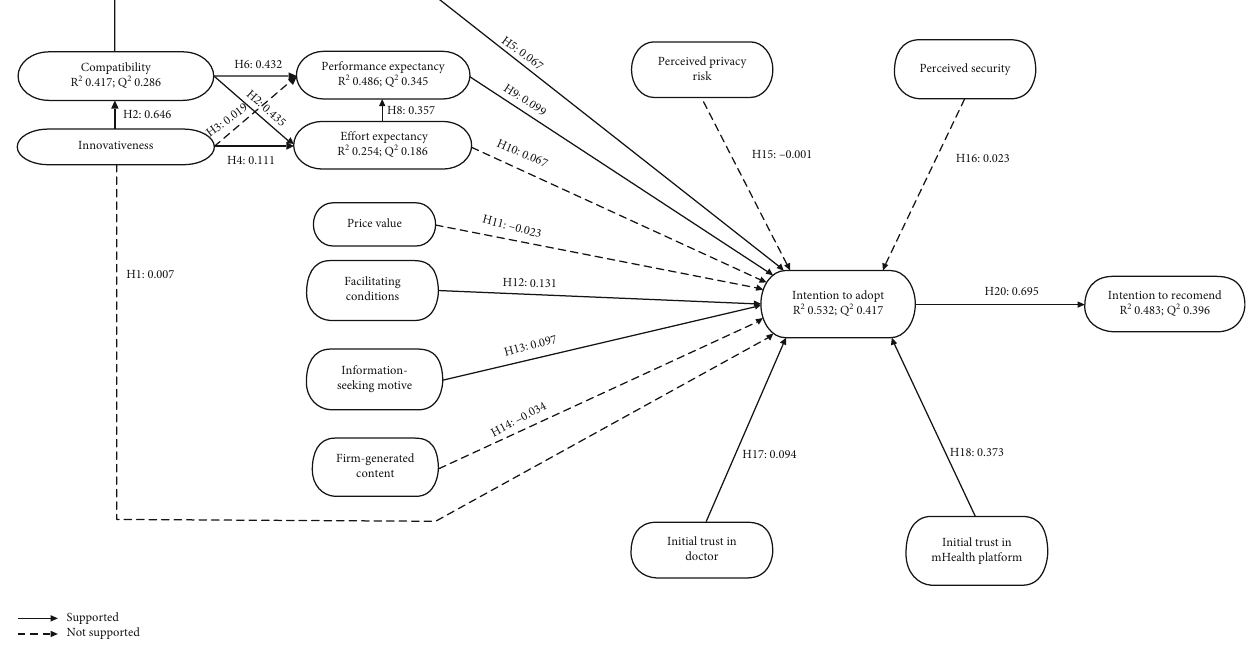
Figure 5: Structural model results.